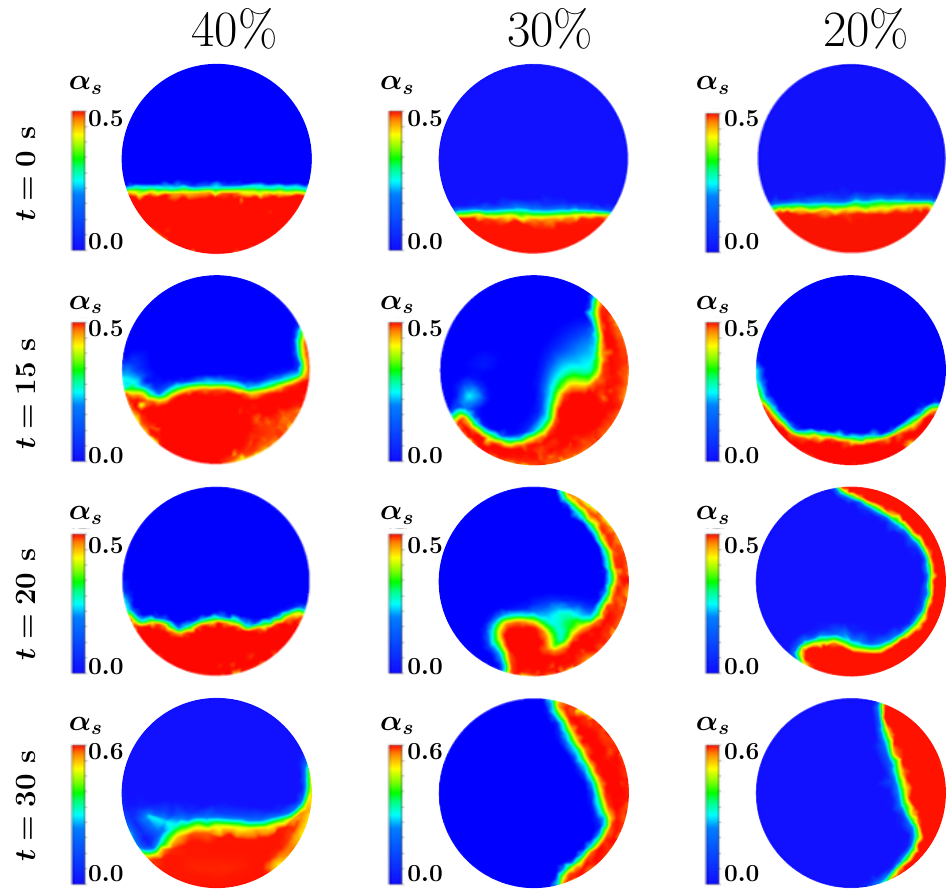
Figure 10. Volume fraction of the the granular solid phase for fill levels of 20%, 30%, and 40% for a drum rotating at 8